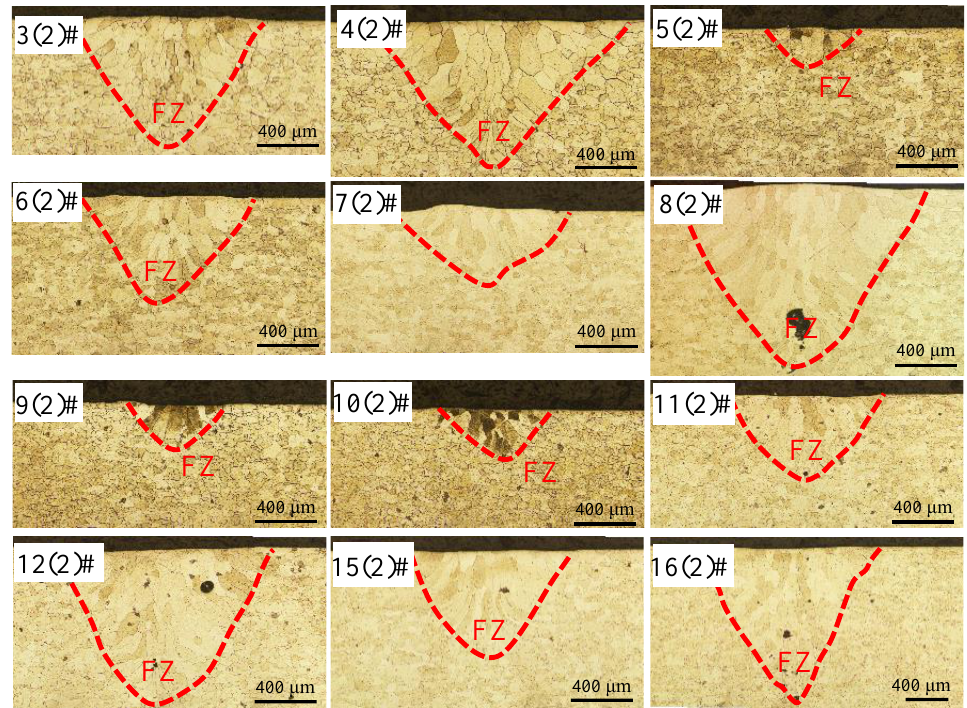
Figure 5. The metallographs of the cross sections of the Mo – Re joints with a thickness of 2 mm, obtained through a three-factor and four-level orthogonal test.